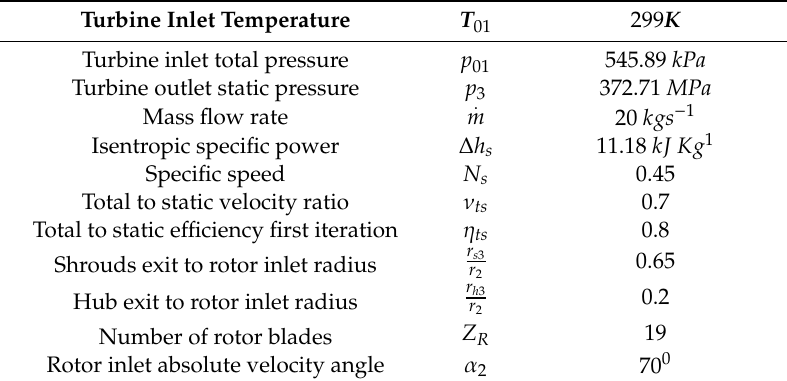
Table 1. Design parameters assumed for the base